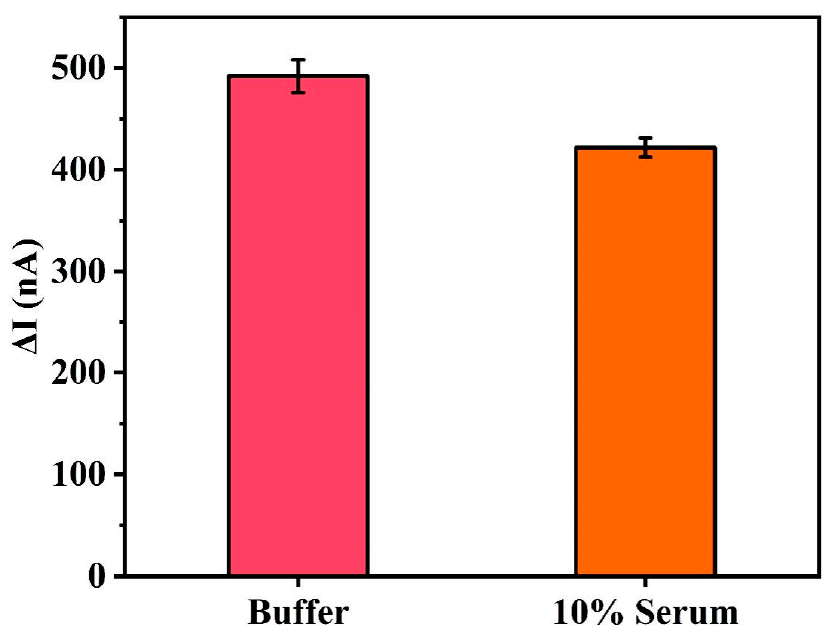
Biosensors 2021 , 11 , x FOR PEER REVIEW Figure 8. Signal difference ( ∆ I) for the electrochemical DNA sensor based on terminal protection challenged with target (1 µ M) in buffer (20 mM Tris-HCl, 100 mM NaCl, 20 mM MgCl 2 ) and complex matrices, such as 10% serum. Error bars represent the standard deviation of the measurement (n = 3).